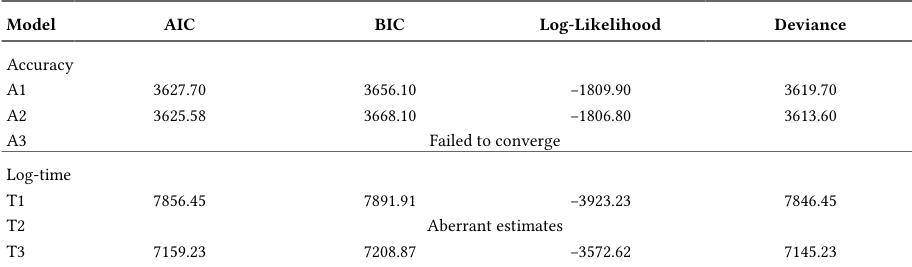
Model Comparison Between Accuracy (Top Panel) and Log-Time (Bottom Panel) Models Model AIC